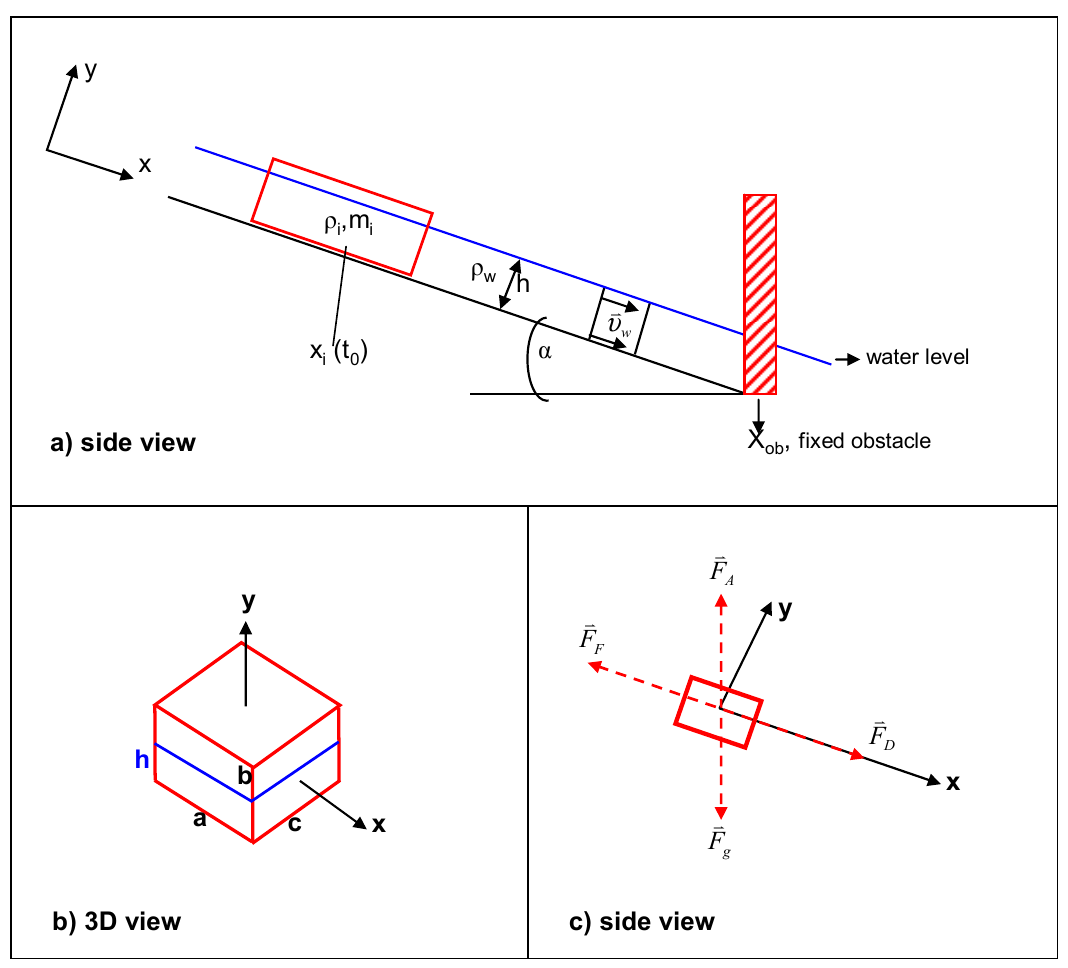
Figure 1. System sketch ( a and b ) and free body diagram ( c